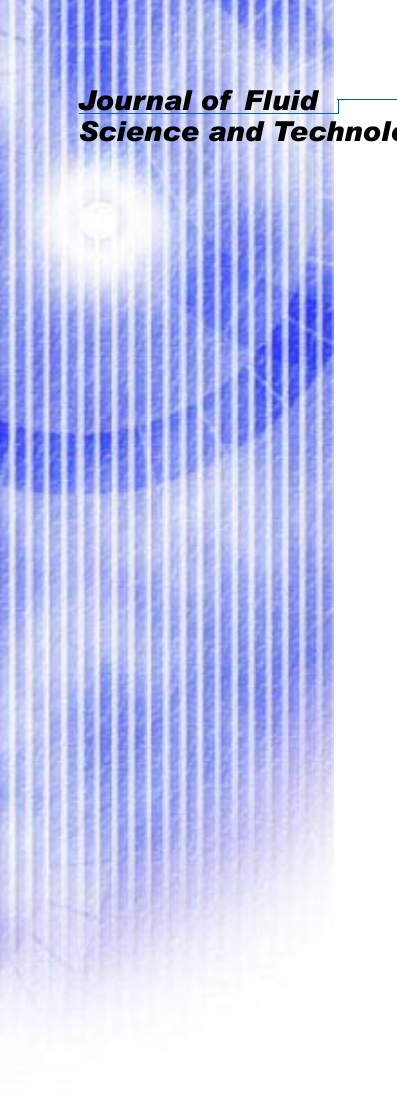
Fig. 15 Axial turbulence intensity